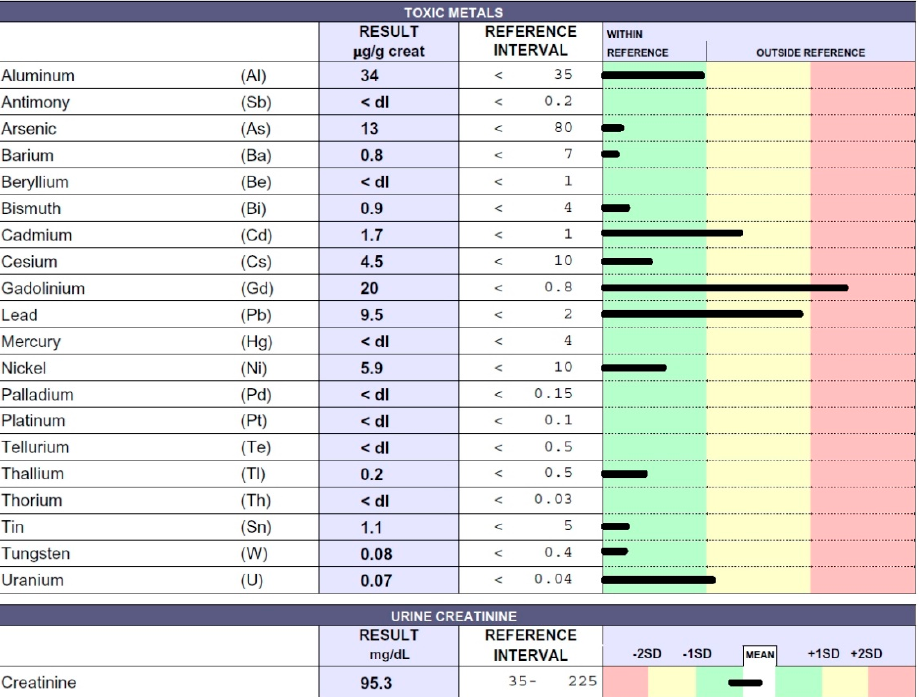
Figure 4. Toxic metal levels measured by ICP-MS method in the patient’s urine collected during the 12 h following EDTA chelation test reported in micrograms (µg) per g creatinine. The 39-year-old woman was affected by MS.